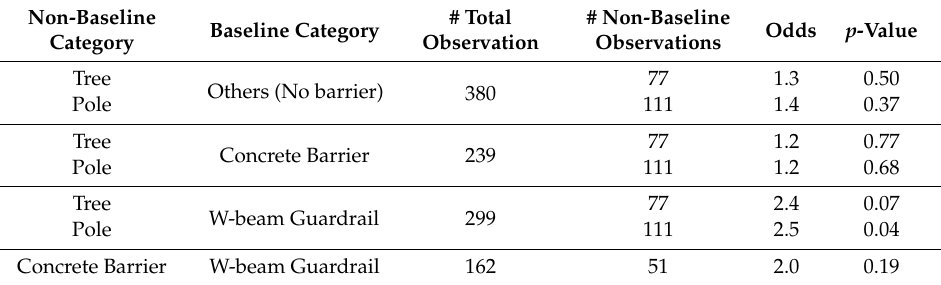
Table 3. Univariate Analysis